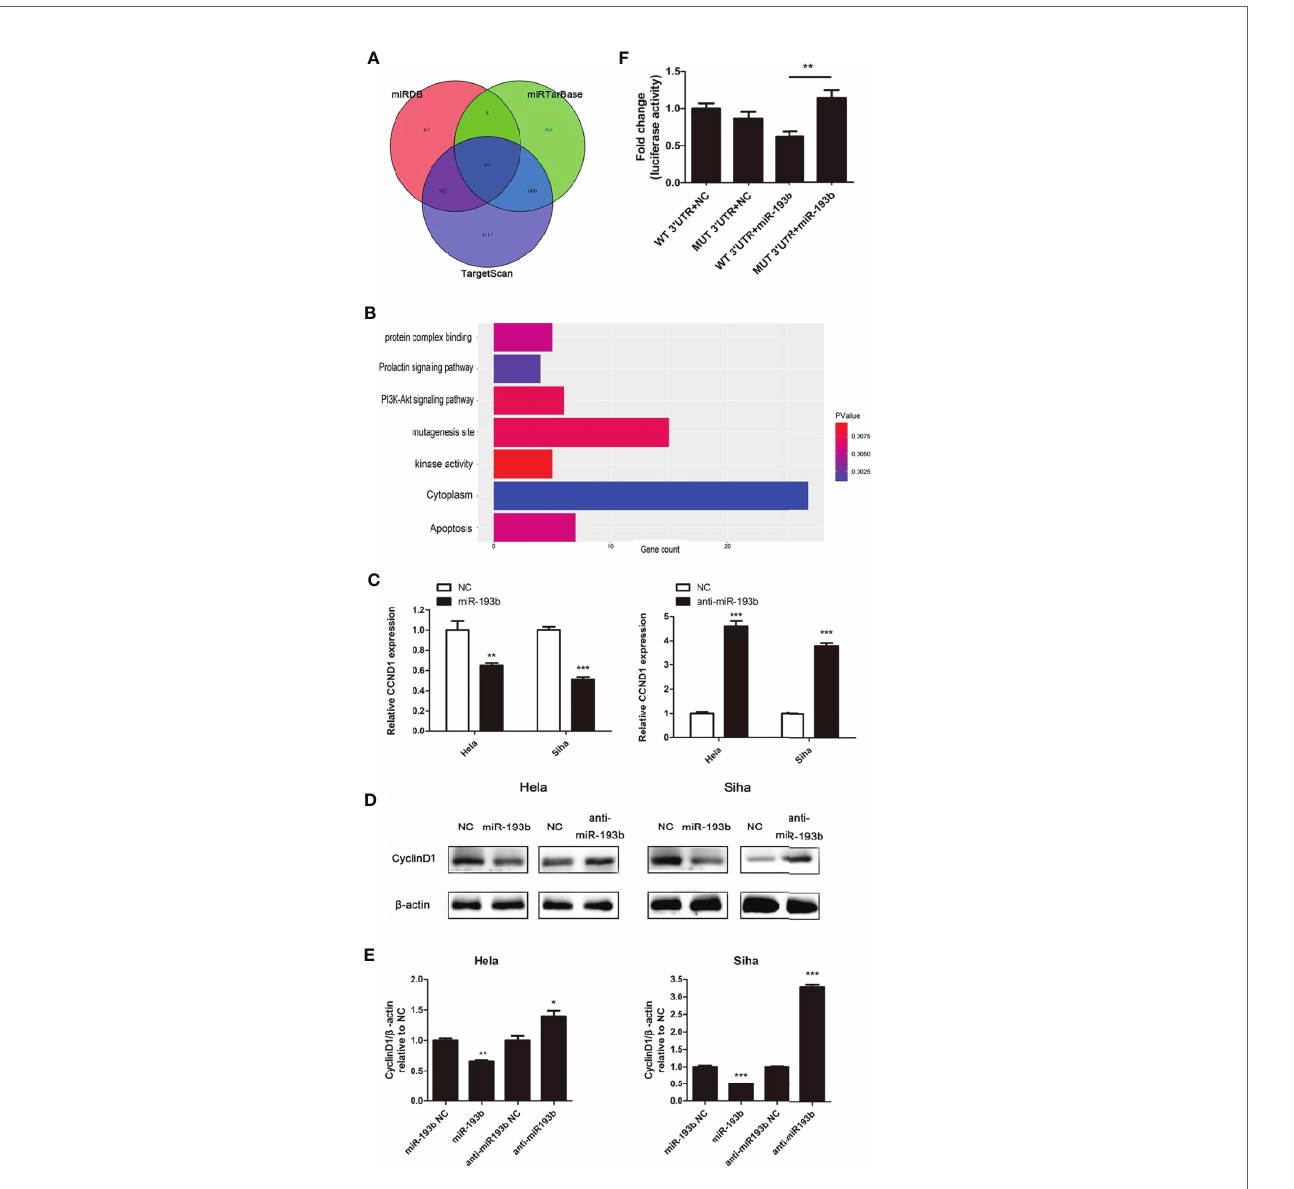
FIGURE 3 | miR-193b regulates the expression of CCND1. Either miR-193b or anti-miR-193b was used to transfect Hela and Siha cells as described. (A) Venn diagrams showed 64 signi fi cantly target genes that appeared simultaneously in miRNA target prediction algorithms TargetScan, miRDB, and miRTarBase. (B) GO analysis was performed on 64 targeted genes. (C) CCND1 expressions were measured by qRT-PCR. (D) CyclinD1 protein expression was detected using Western blot. (E) Band density of Western blot was examined using ImageJ, and protein levels were normalized to b -actin. (F) 3 ′ -UTR luciferase reporter assay was utilized to determine the binding of miR-193b to the 3 ′ -UTR of CCND1. Luciferase activities of WT or MUT CCND1 3 ′ -UTR luciferase construct co-transfected with miR-193b or NC in HEK-293T cells were measured. * p < 0.05, ** p < 0.01, *** p < 0.001.